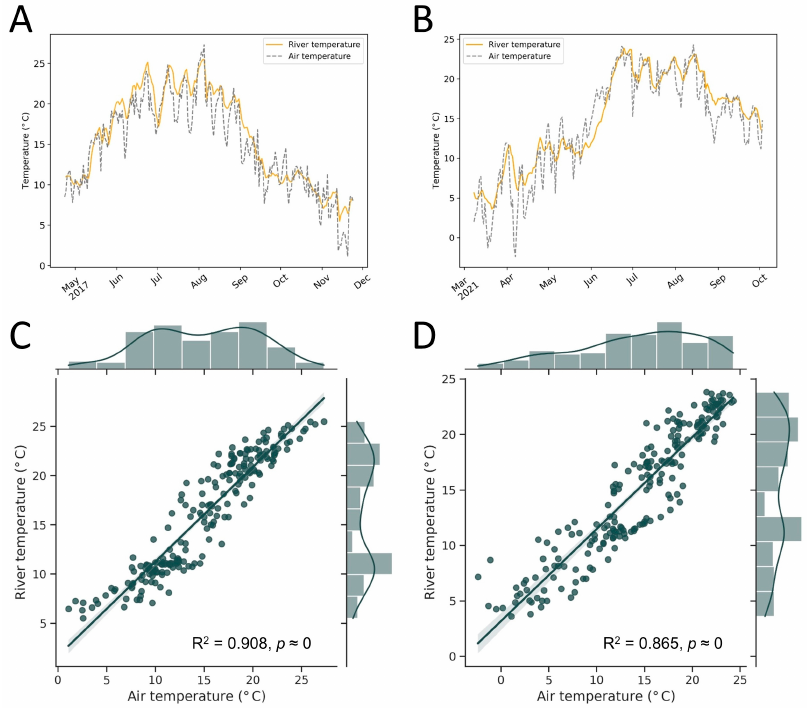
Figure 7. ( A , B ) Air temperature recorded by the ARSO meteorological station at Postojna and the water temperature in the Pivka River and ( C , D ) temperature regression plot in 2017 and 2021, re- spectively.